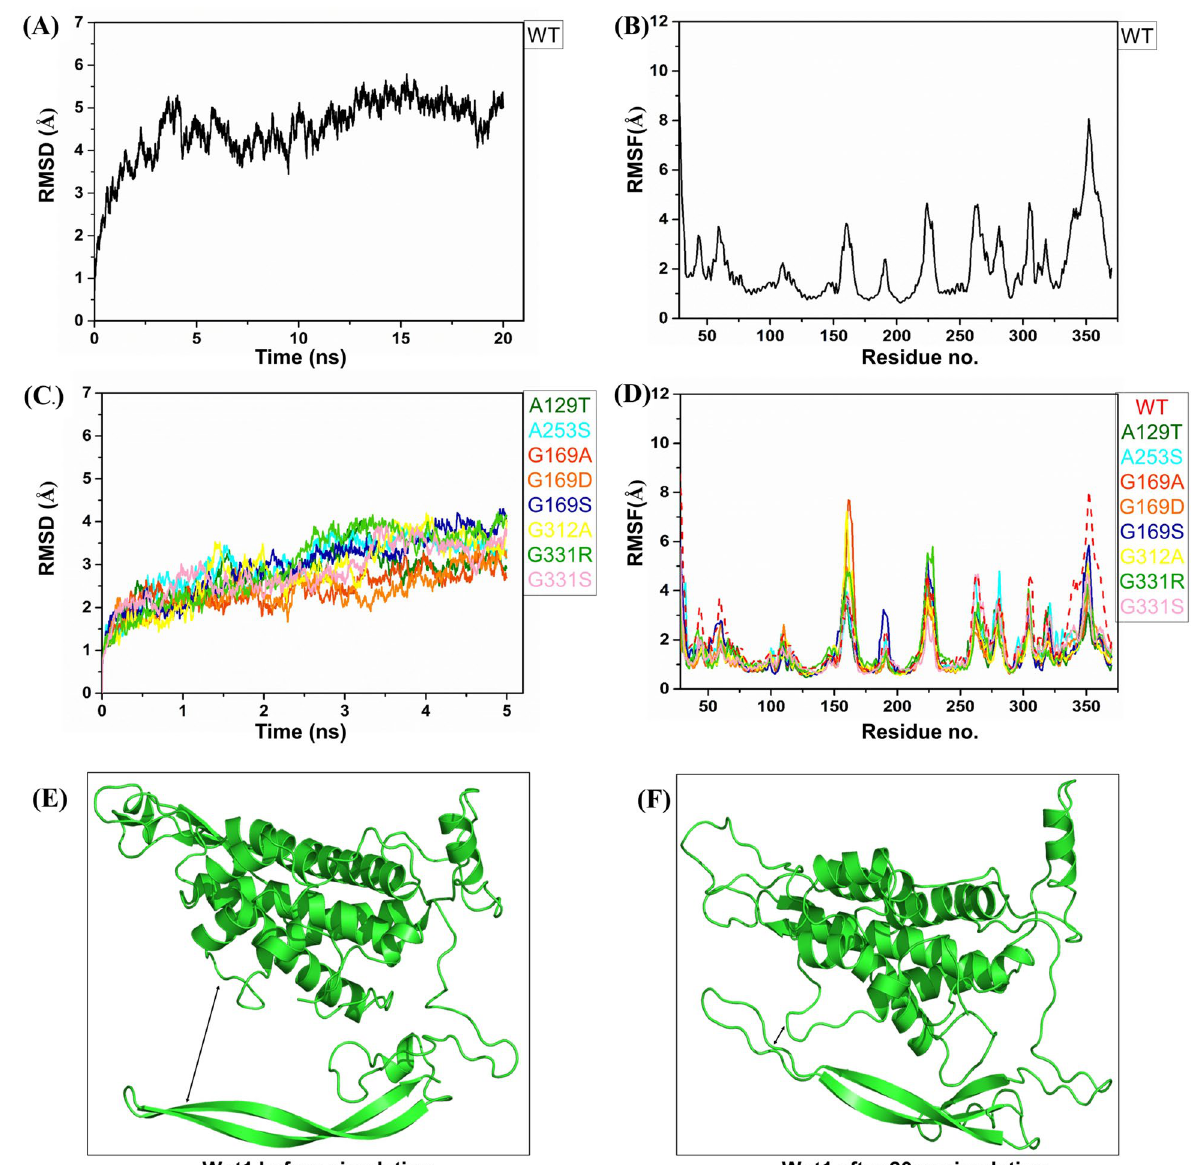
Figure 2. RMSD of Cα atoms of Wnt1 in ( A ) WT and ( C ) Mutated form in apo states. RMSF of Cα atoms of Wnt1 in ( B ) WT and ( D ) Mutated form in apo states. ( E ) Modelled structure of Wnt1 before MD simulation, showing open binding pocket marked in black arrow. ( F ) Structure of Wnt1 after the 20 ns MD simulation, showing the binding pocket is closed (shown in black 3.5 and 5.5 Å (Fig. 2A). The initial rise of RMSD upto ~ 5 Å was because of the event of closure of the binding pocket (Fig. 2E,F) and this observation was in agreement of earlier reports in absence of the ligands 52 . So the MD simulation seemed to be able to benchmark the literature data and reflects the reliability. Root Mean Square Fluctuation (RMSF), of Cα atoms, averaged over the MD trajectories, showed ~ 2 Å fluctuation of the folded region while little higher values were noted in the unstructured loop regions (Fig. 2B). For the mutated systems, the RMSD values were limited within 4.5 Å (Fig. 2C) and the RMSF values followed the trend of < 2 Å for folded regions and higher values for unstructured regions (Fig. 2D). Interestingly, RMSF of the residues within 330–360 (CTD region) were lower compared to that of WT (Fig. 2D). This was because the binding pocket of all the mutants were already closed at the starting point of the MD as they were modelled based on the last conforma- tion obtained after the 20 ns MD run of WT; as mentioned earlier the WT experienced the closure of the binding pocket during MD. Orientation of the side chains of the mutated residues were visually inspected using VMD 69 before and after the MD simulations; the observed deviations were summarized in Fig. 3. Interaction of WNT-1 with frizzled receptors. As Wnt ligands bind at the Cysteine-rich Wnt-binding domain (CRD) of frizzled receptors (FZDs), Wnt1 has been docked against the CRDs of FZD-1, FZD-2, FZD-4,